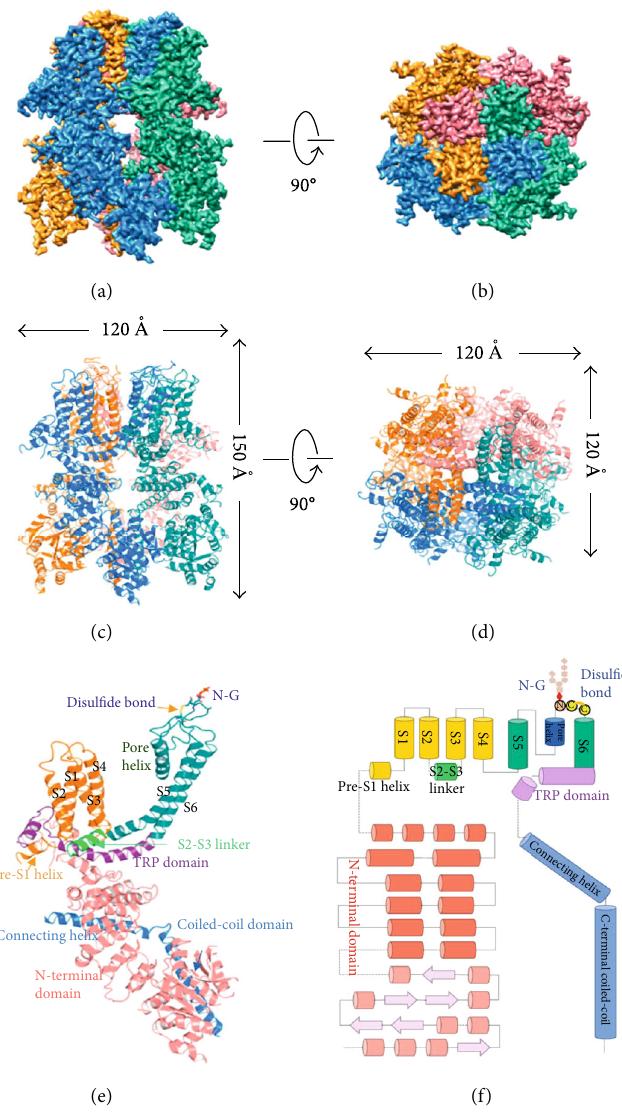
Figure 1: Overall structure of human full-length TRPM4 in the apo state. (a, b) Side and top views of the cryo-EM reconstruction density map of human TRPM4 at 3.7 Å overall resolution. (c, d) Ribbon diagrams representing the same orientation and colors with the channel ’ s dimensions indicated. (e) Structural details of a single human TRPM4 subunit. (f) Linear diagram depicting the major structural domains, color coded to match the ribbon diagram. The N-linked N992 glycosylation site (N-G) and the Cys993-Cys1011 disul fi de bond are indicated; reprinted from